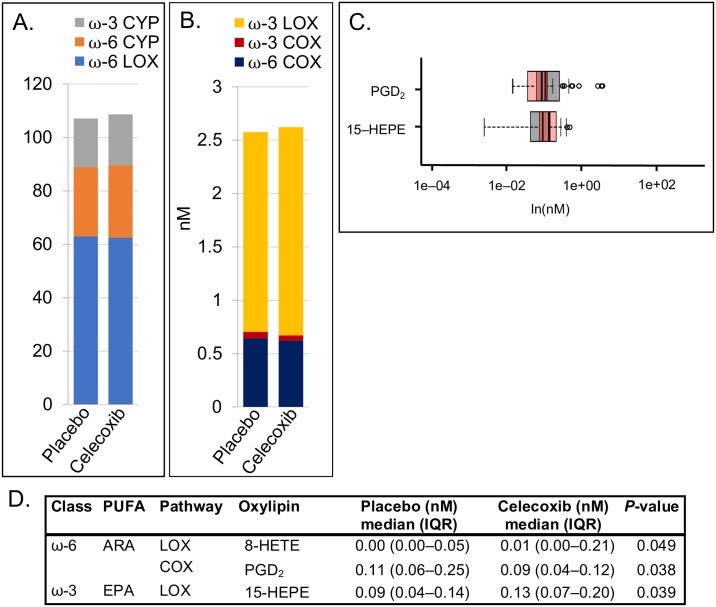
Celecoxib (n = 36) versus placebo (n = 46) among aspirin users only.(A) Summed oxylipins from ω-3 CYP450, ω-6 CYP450, and ω-6 LOX pathway arms. (B) Summed oxylipins from ω-3 LOX, ω-3 COX, and ω-6 COX pathways arms. Note that A and B are on different scales. Different colors represent the sum of all quantified oxylipins in a given pathway arm. (C) Overlapping box plots showing significantly different individual oxylipins between placebo (gray) and celecoxib (pink) groups. (D) Median (IQR) levels of oxylipins that are significantly different between groups, with Wilcoxon rank-sum test P-values. Note that the median value for 8-HETE among the Placebo is below the limit of quantitation (< 0.0008 nM).